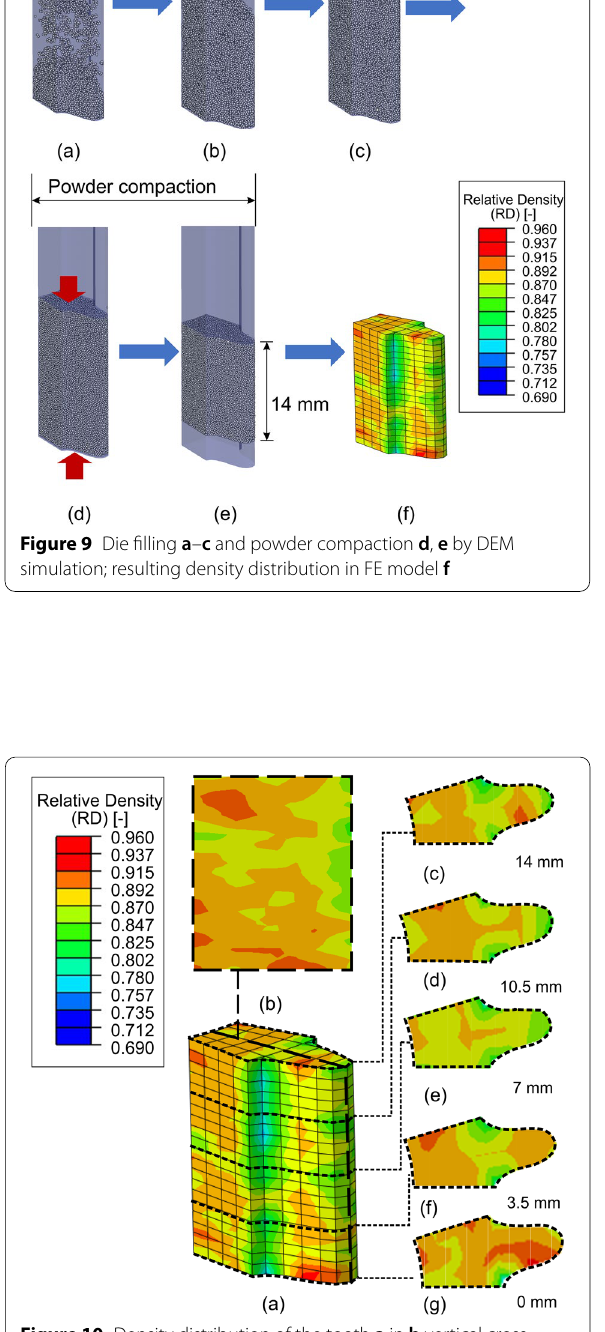
Figure 10 Density distribution of the tooth a in b vertical cross section of a gear element and c – g in horizontal cross sections at different